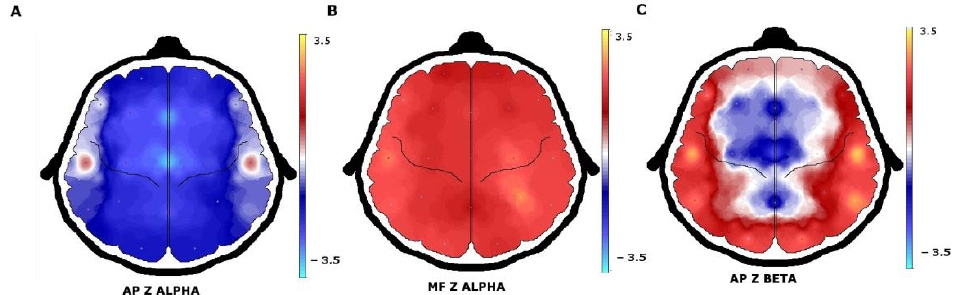
Figure 2. QEEG with neurometric analysis of patients with juvenile myoclonic epilepsy. ( A ) A generalized decrease in alpha absolute power in the frontocentral regions with ( B ) an increase in alpha mean frequency. ( C ) The beta absolute power increase was observed in the temporal and occipital regions.